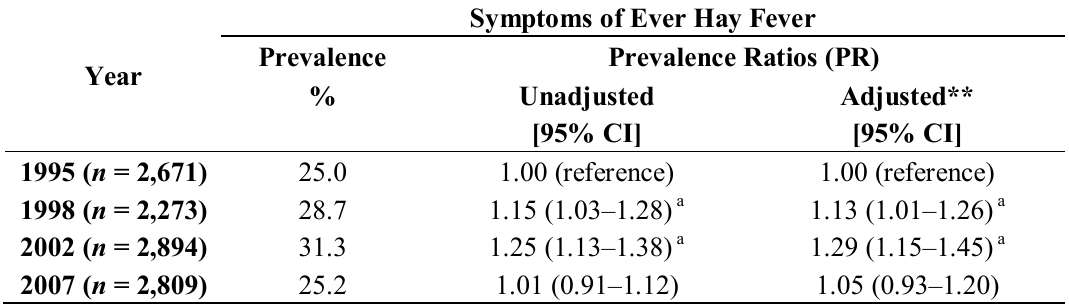
Table 3. Unadjusted and adjusted Prevalence Ratios (PR) of symptoms of ever hay